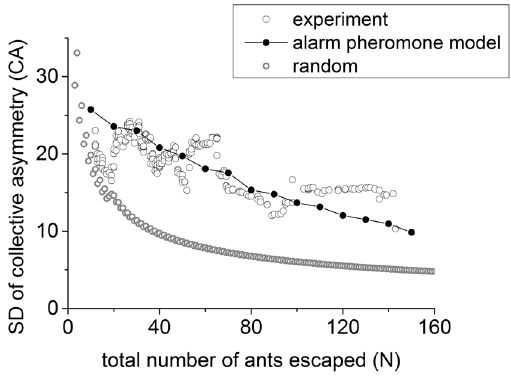
Fig. 6. The standard deviation of CA u s : N . The simulation result (solid dots) produced by the alarm pheromone model agrees well with the experimental result (circle), and both differ from the random results (gray circle). The solid dots (simulation result) are averaged over 1000